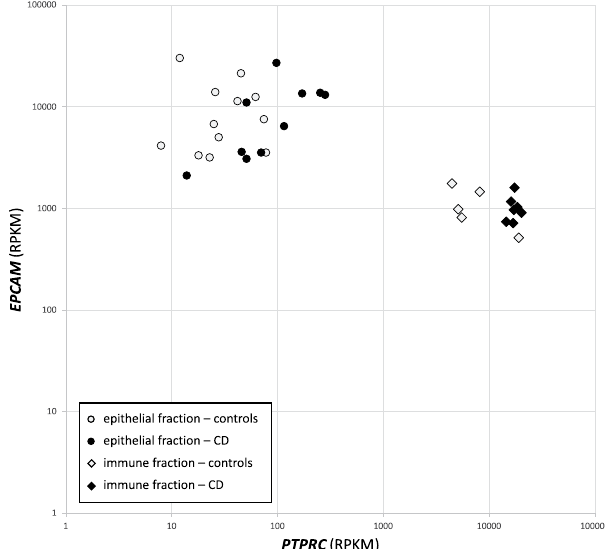
Figure 1. The efficiency estimation of the cell separation. The relative expression (normalized RNAseq counts) of EPCAM and PTPRC was used to account for the efficiency of the cell separation through the estimation of the proportion of the epithelial cells and the IELs, respectively. The purity of the epithelial and the immune fraction (expressed as EPCAM : PTPRC and PTPRC : EPCAM ) was 99 ± 1% and 90 ± 7%,